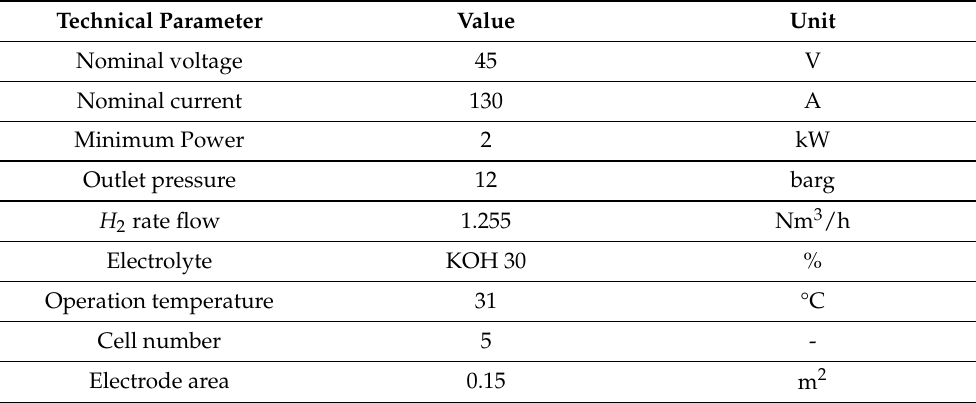
Table 2. Technical specifications of the alkaline